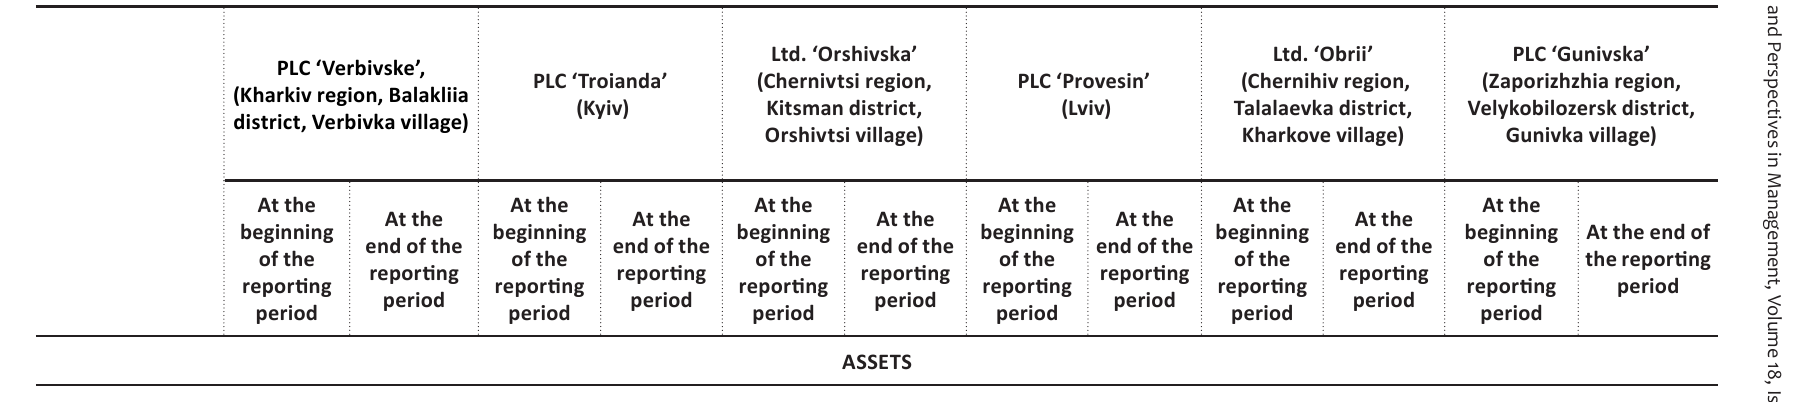
Source: Developed by the